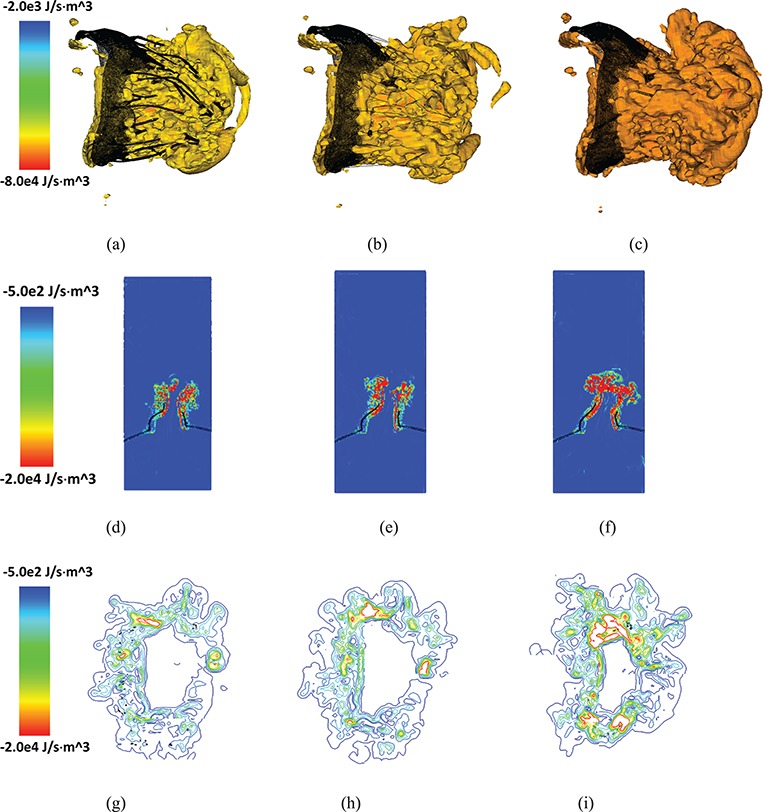
Isovolume plots for energy dissipation function (\documentclass[12pt]{minimal}
\usepackage{amsmath}
\usepackage{wasysym}
\usepackage{amsfonts}
\usepackage{amssymb}
\usepackage{amsbsy}
\usepackage{upgreek}
\usepackage{mathrsfs}
\setlength{\oddsidemargin}{-69pt}
\begin{document}
}{}$\varPhi $\end{document}) for (a) the complex model, (b) pseudo-fibre model and (c) simplified model. The corresponding 2D sliced views and contour plots around the chordal cross-sections of \documentclass[12pt]{minimal}
\usepackage{amsmath}
\usepackage{wasysym}
\usepackage{amsfonts}
\usepackage{amssymb}
\usepackage{amsbsy}
\usepackage{upgreek}
\usepackage{mathrsfs}
\setlength{\oddsidemargin}{-69pt}
\begin{document}
}{}$\varPhi $\end{document} are shown in (d, e and f) and (g, h and i), respectively. See online version for colours.